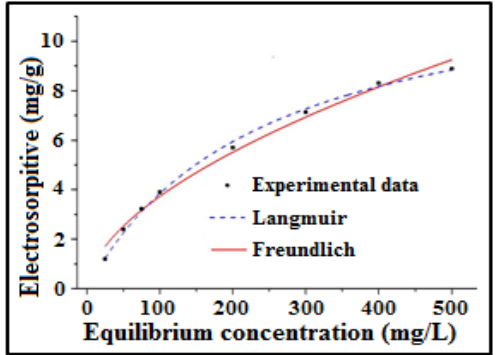
Figure 12. The electrosorption isotherm for the 23.58 wt% a-SWCNT-coated RVC electrode at a flow rate of 50 mL/min NaCl and a voltage of 1.5 V.